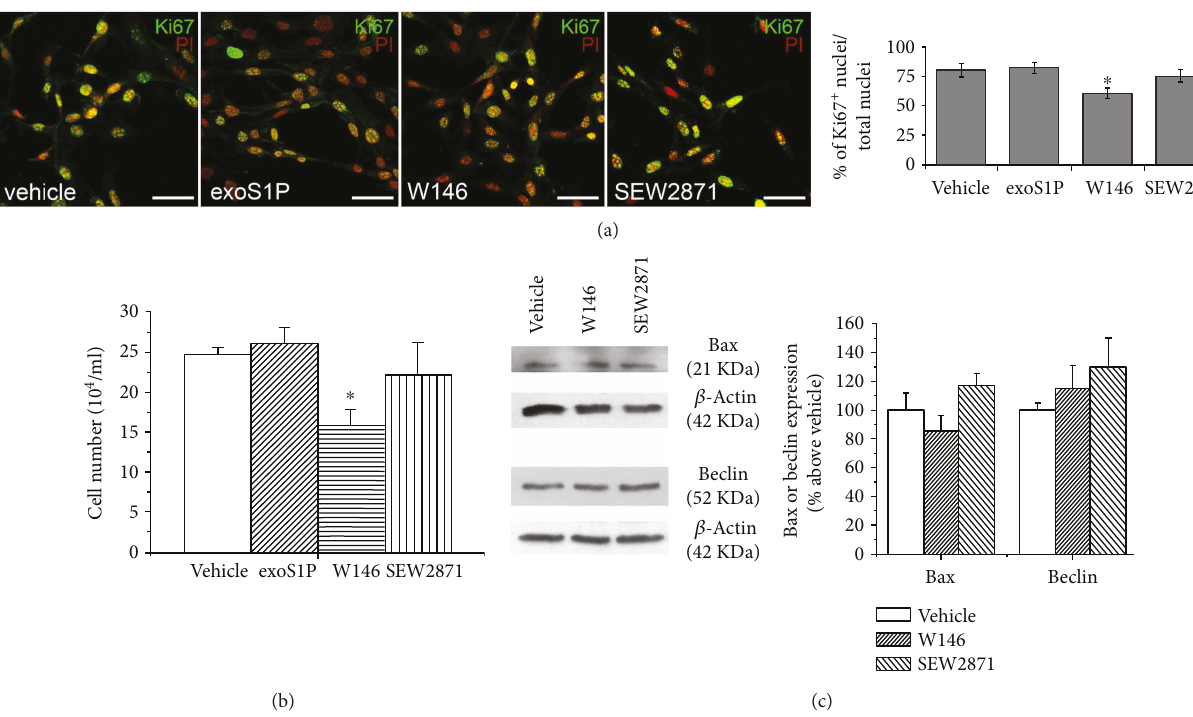
Figure 4: Cell proliferation and toxicity. BM-MSCs were incubated in growth medium for 24 h in absence (vehicle) or in presence of 1 μ M exogenous sphingosine-1-phosphate (exoS1P), 2 μ M S1PR1 receptor antagonist, W146, or 2 μ M S1PR1 receptor agonist, SEW2871. (a) Representative confocal immuno fl uorescence images of Ki67 expression. BM-MSCs were immunostained with the speci fi c antibody Ki67 (green), a nuclear proliferation marker, and counterstained with propidium iodide (PI; red). Yellow colour indicates colocalization of